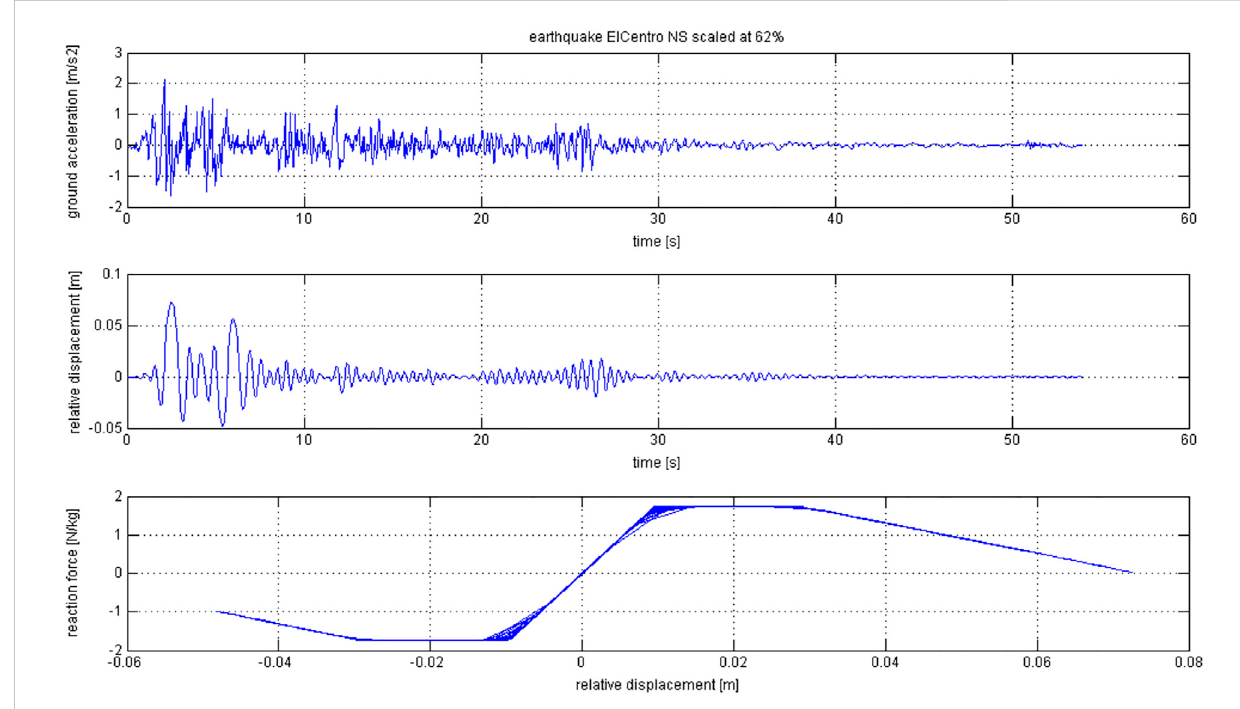
FIGURE 5 Non-linear computed response for 62% of El Centro. The wall practically reaches the onset of overturning.